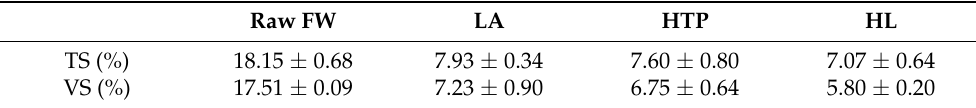
Table 2. Contents of TS and VS in FW used for different pretreatments.